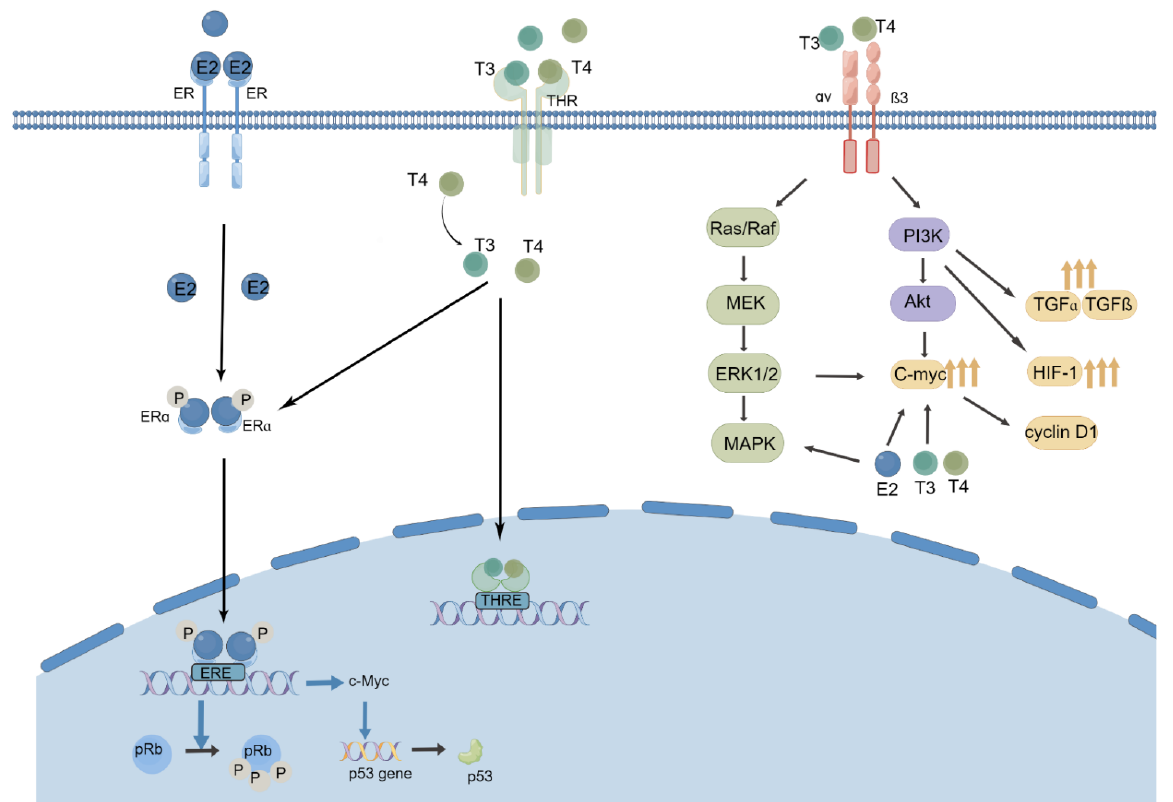
Figure 2. Thyroid hormone and estrogen-mediated signaling pathway.Estrogen and TH enhance nuclear localization of both THR α and ER α in breast cancer cells. Thyroid hormones facilitate the genomic effect of estrogen through ERa which bind estrogen response elements (ERE) [48]. Thyroid hormone and E2 regulate p53 and pRb(retinoblastoma protein) together ( Left ) [49]. TH can induce aberrant activation of MAP kinase and the PI3 kinase signaling pathways by binding α vß3 integrin as well. Metastasis and proliferation of BC is improved by increased C-myc, which is activated by the MAP kinase pathway [18]. TH could induce the high expression of hypoxia inducing factor 1 (HIF-1) and transform growth factor alpha (TGF α ) in BC cell lines by activating the PI3K pathway ( Right )